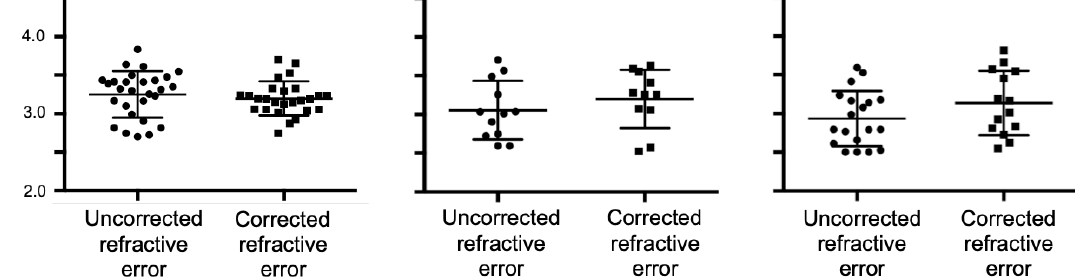
Figure 3. Scatter plot with mean and standard deviation of microsaccade (A-C) and saccadic (D-F) frequencies by the severity of myopia in uncorrected and corrected refractive error conditions during the visual search task. Each point in all the plots represents data obtained during one spot the difference trial. Frequency of microsaccades generated was higher with corrected refractive error in the severe myopia group. There were no significant differences in the frequency of saccades between the three